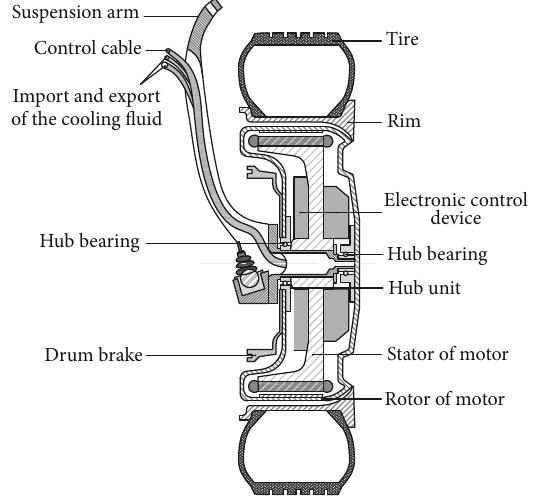
Figure 1: Structure of the IWM-driven system.